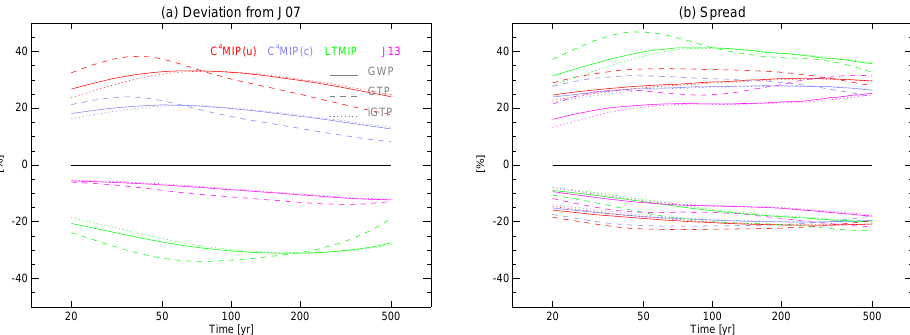
Fig. 4. Impact of variation in IRF CO 2 on GWP (full line), GTP (dashed line), and iGTP (dotted line), using the C 4 MIP(u) (red), C 4 MIP(c) (blue), LTMIP (green), and J13 (purple) IRF CO 2 . (a) Difference between the median of the obtained metric distribution and the value obtained using the reference J07 IRF CO 2 . (b) Spread of the obtained metric distribution, indicating the difference between the 5-percentile value and the median value (lower lines), and between the 95-percentile and median value (upper lines). These impacts are equal for all species (BC, CH 4 , N 2 O, and SF 6 ).